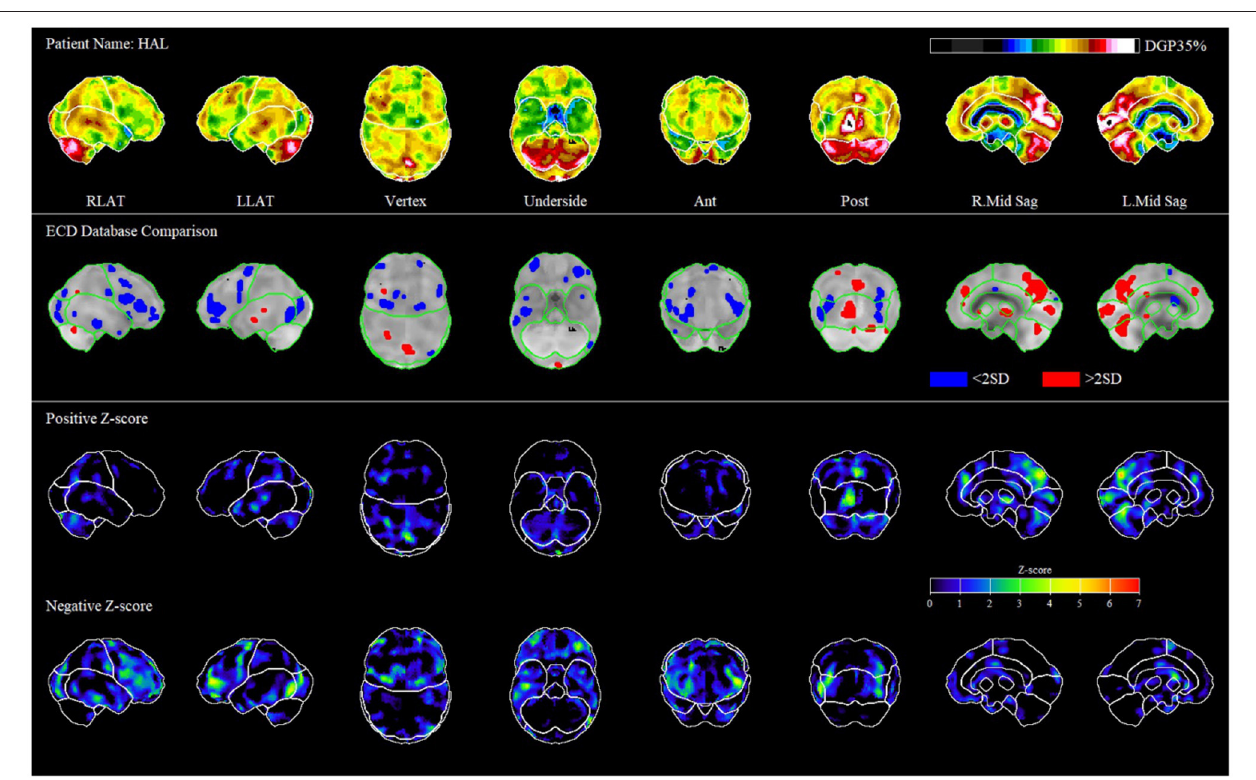
FIGURE 1 | Representative patient case. The first row of images shows different levels of perfusion relative to the maximum perfusion level in the brain (occipital lobe in ethyl cysteinate dimer, ECD). In the second row of images, we compare the patient to the average of normal scans in the database. Hypoperfusion is in blue, and hyperperfusion is in red; only pixels > 2 standard deviations from normal are shown. In the third and 4th rows of images, we represent the positive and negative Z-scores, which outline the regions of heightened and diminished perfusion relative to